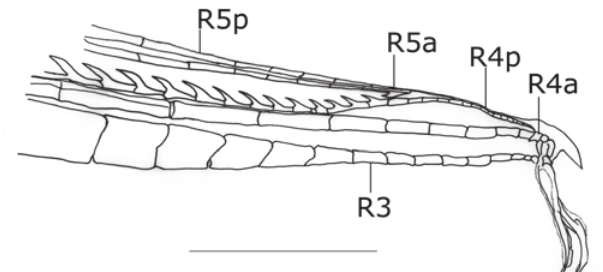
Fig. 49. Gonopodium tip of Phalloceros spiloura , MCP 29270. (a) ventrolateral view; (b) lateral view. R3, R4a, R4p, R5a, R5p indicate gonopodial rays. Scale bar 1